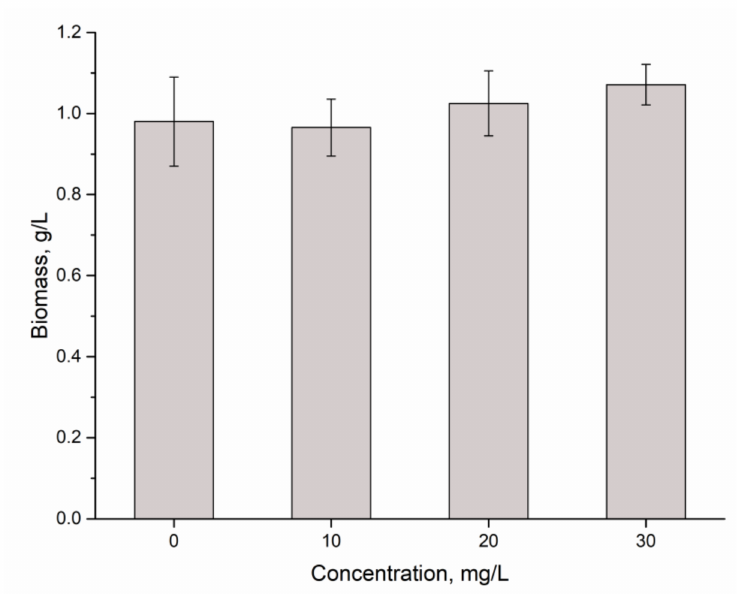
Figure 4. Influence of Eu(III) applied at a concentration of 10–30 mg/L on the A. platensis